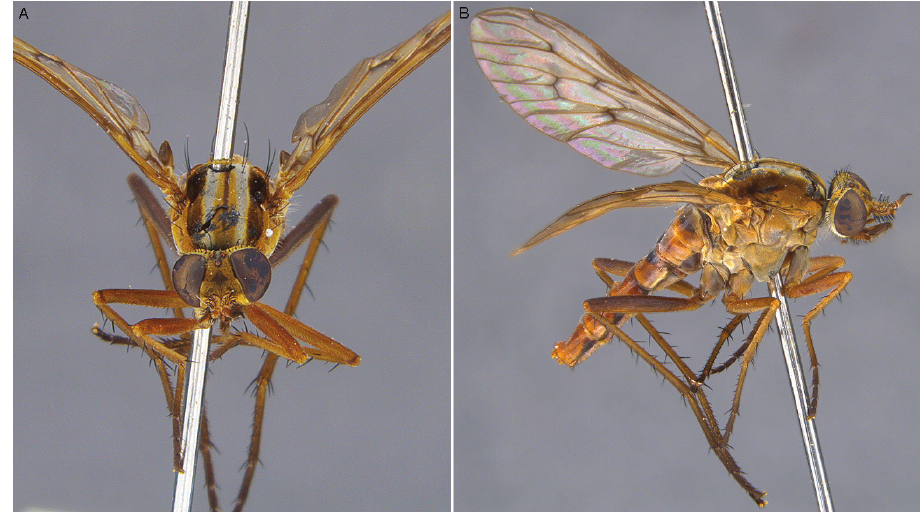
Figure 15. Sidarena macfarlandi sp. n.: A Female anterior view B same, lateral view. orange dorsally, darker suffusion ventrally, pleuron with fine white pile on anepister- num and katatergite; chaetotaxy: np, 3–4; sa, 2; pa, 1; dc, 3; sc, 1; wings infuscate, darker along veins, more distinctive and extensive around crossveins to give mottled appearance; venation dark; coxae dark, overlain with grey pubescence; femora dark yellow-orange with dark suffusion more pronounced on hind femur; tibiae and tarsi dark yellow-orange, distal tarsomeres blackish. Abdomen . Mostly dark